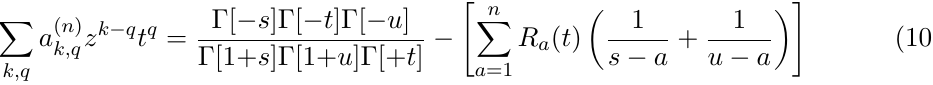
. We see that as we go α 0